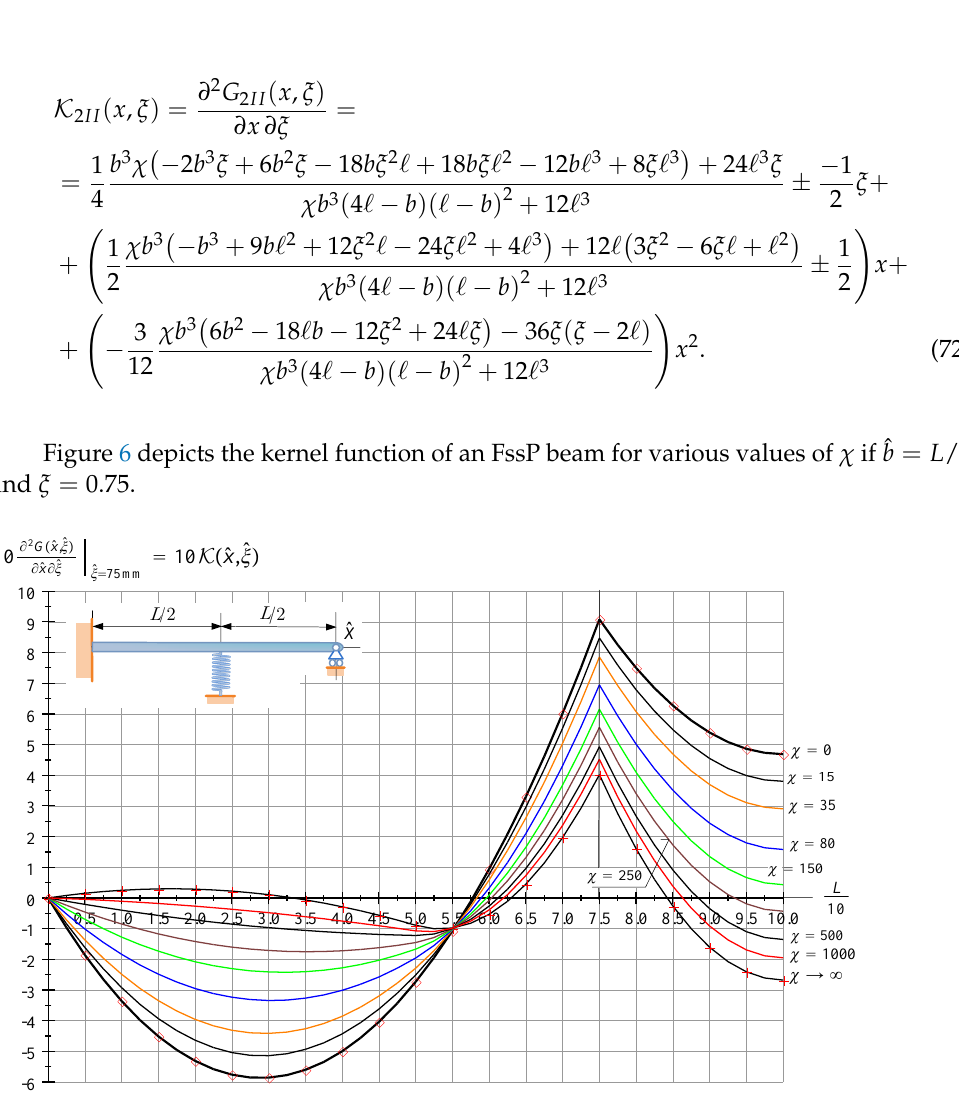
Figure 6. The kernel function of an FssP beam against x = ˆ x / L ; χ is a parameter and ξ =